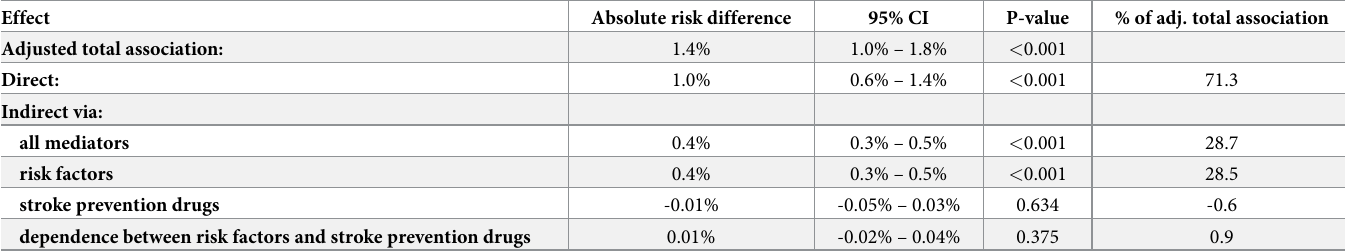
Table 3. Adjusted total association, direct and indirect effects estimated as absolute risk differences (excess risks).